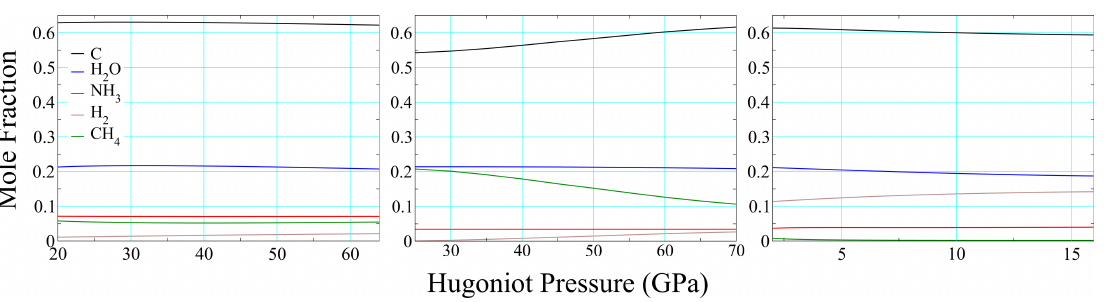
Figure 12. Chemical composition of the product mixture along the products Hugoniot of solid PMDI polyurethane ( left ), epoxy ( center ) and 75% porous PMDI polyurethane ( right